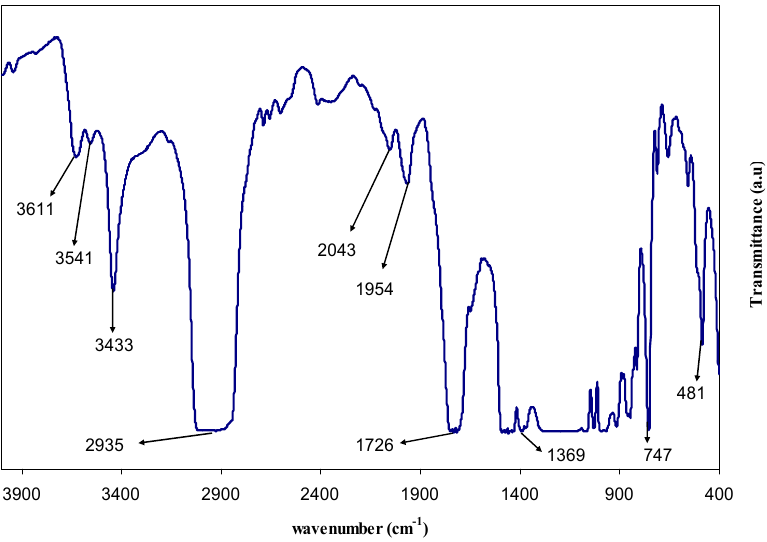
Figure 3. FTIR spectra of pure PMMA polymer (GT 0). It is obvious that the peaks are sharp and their intensity is high.